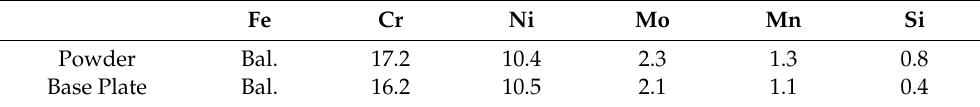
Table 2. Chemical composition (wt.%) of austenitic stainless steel 316L.